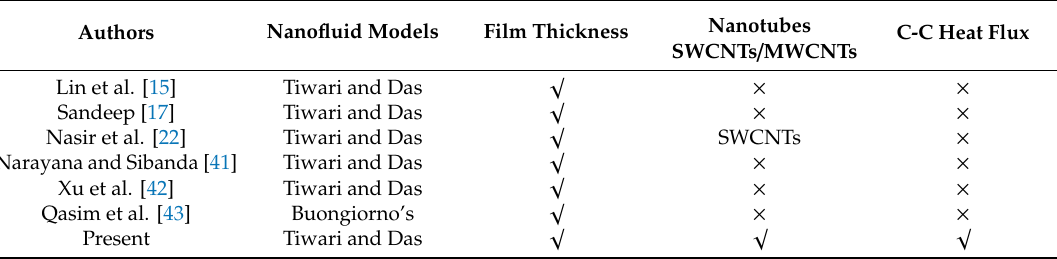
Table 1. The studies on nanoliquid film